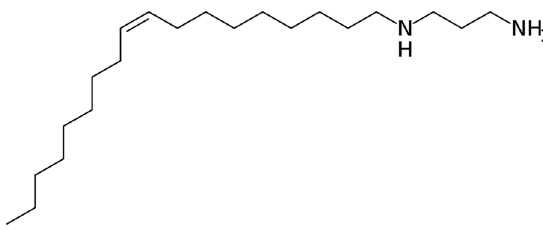
Figure 2. Structural formula of oleyl propylene diamine (OLDA).